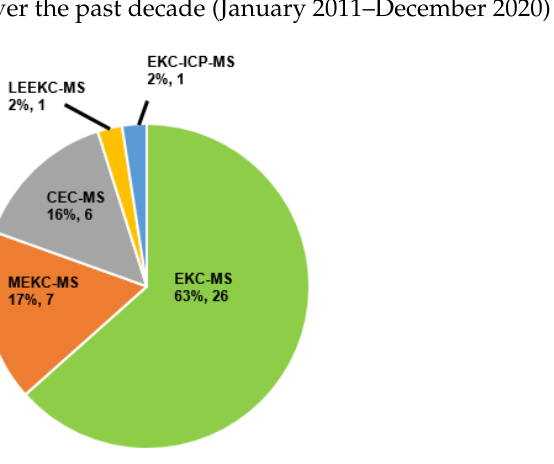
Figure 1. A pie chart illustrates the distribution of articles published on chiral CE-MS modes over the past 10 years ( 2011–2020).